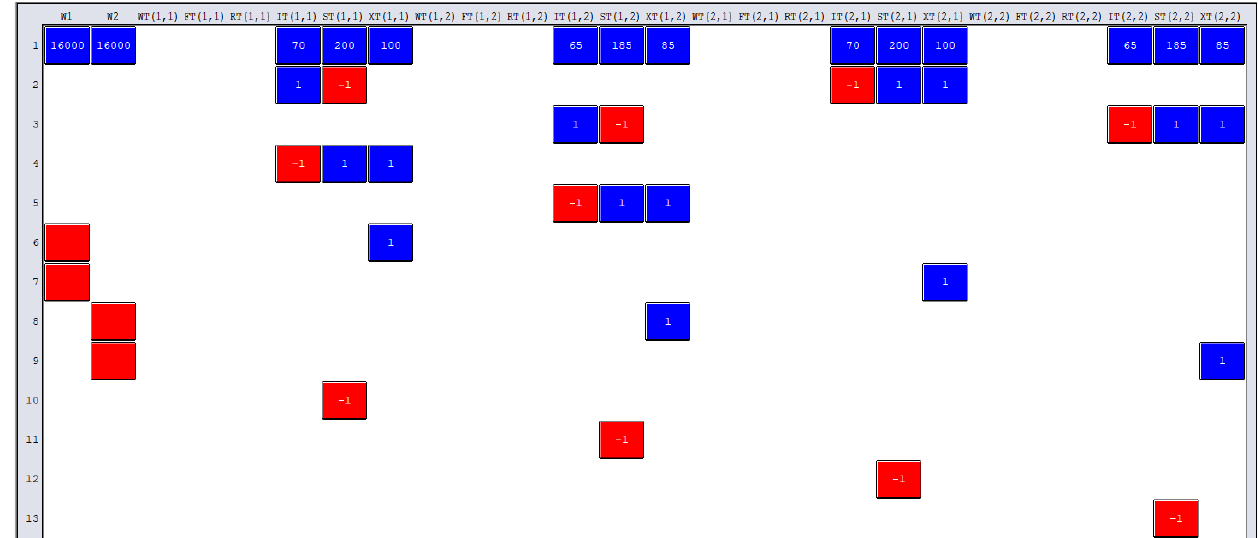
Figure 1. Matrix structure of the developed models, developed in LINGO 19.0.